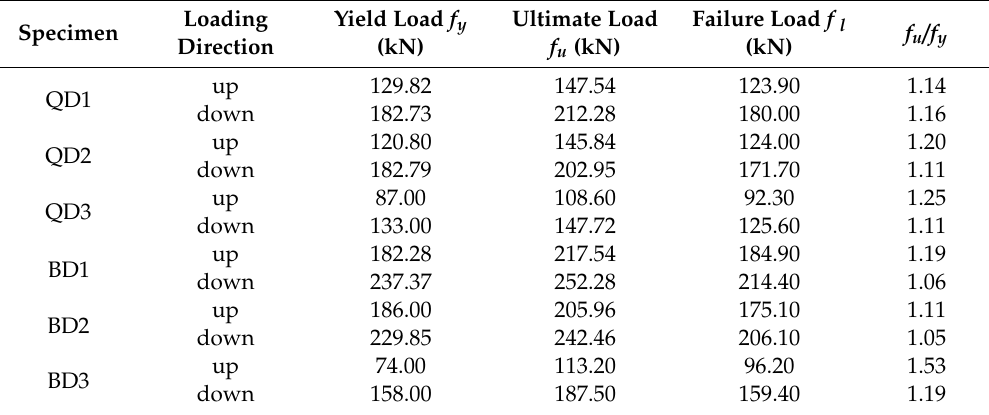
Table 4. Strength of six specimens in two loading directions.